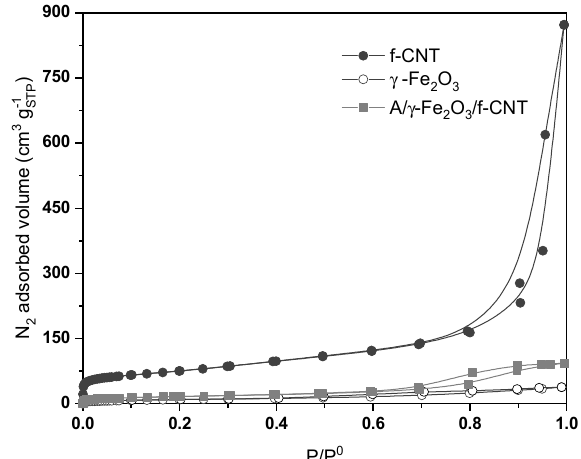
Figure 1. N 2 adsorption-desorption isotherms at 77 K of f-CNT, γ -Fe 2 O 3 particles and A / γ -Fe 2 O 3 / f-CNT beads.